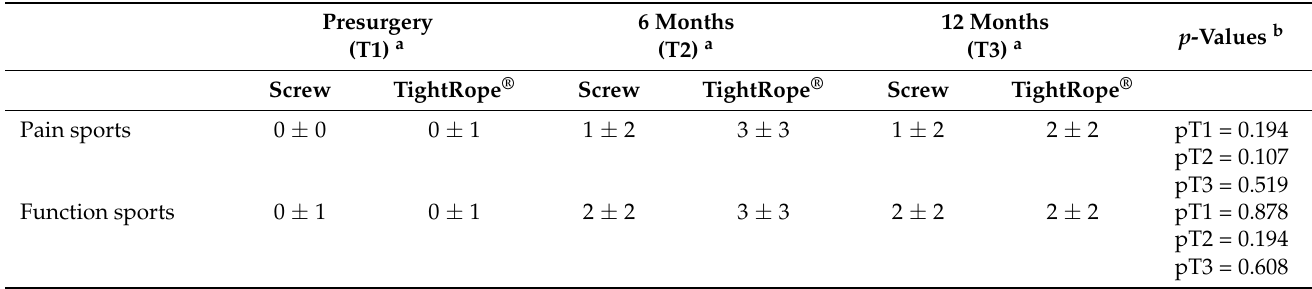
Table 4. VAS Score Pain and Function during